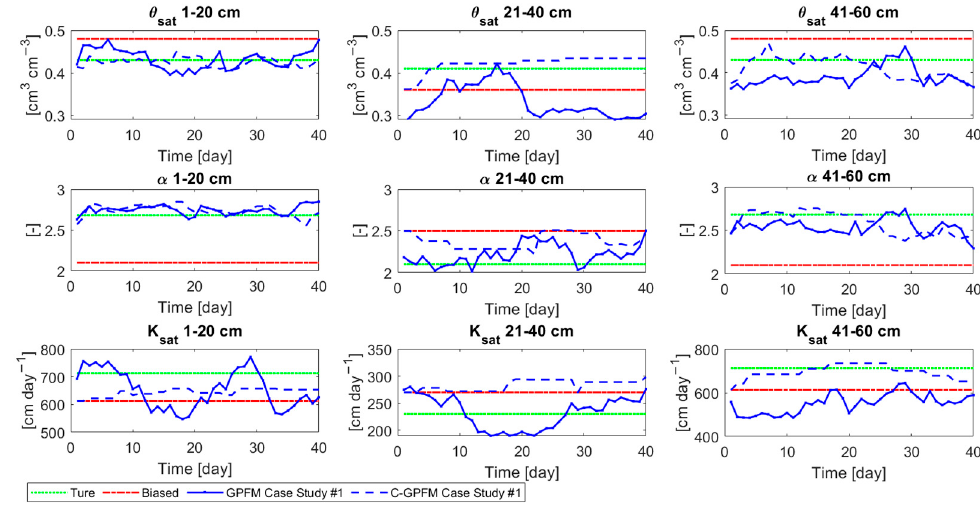
Figure 3. Average of parameters posteriors by C-GPFM and GPFM together with the ’true’ and ’biased’ values for Case Study #1.